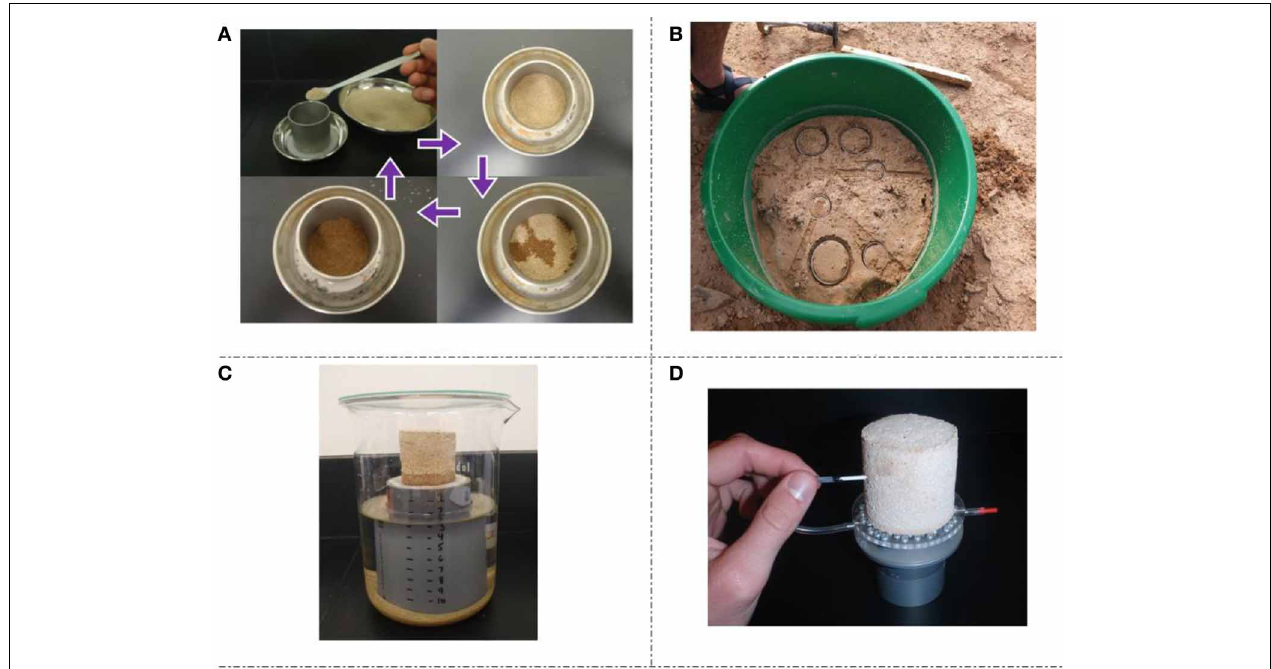
FIGURE 2 | Steps for preparing the soil samples for TypoSoil™ analyses: (A) preparing disturbed soil sample, (B) taking undisturbed soil samples from the field, (C) saturating the unconfined soil samples by capillary through